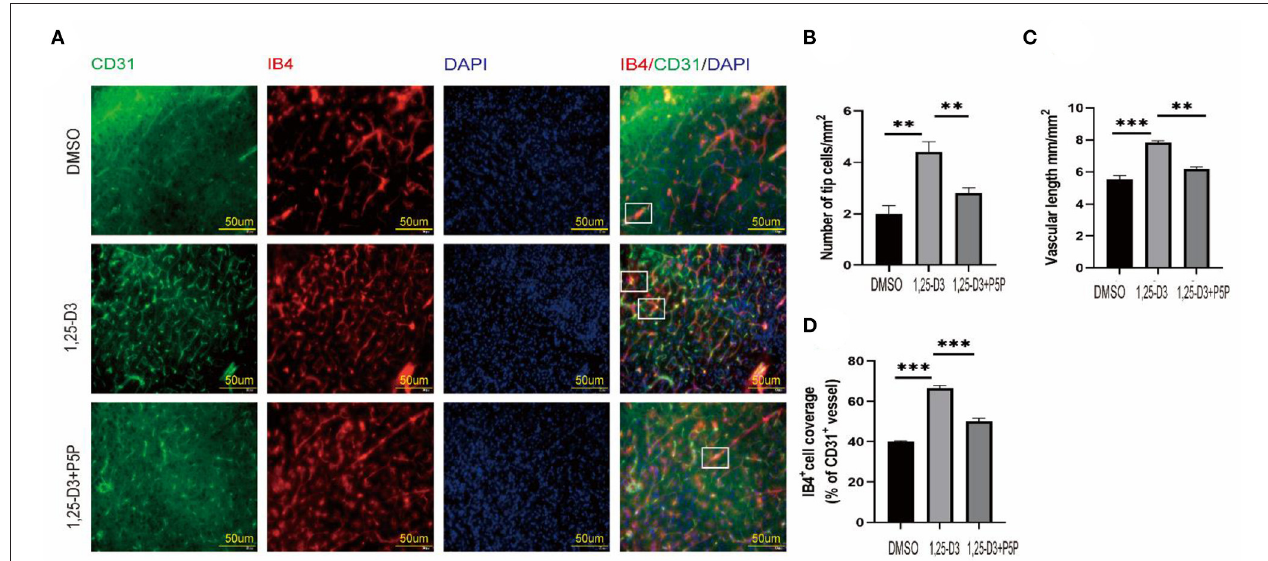
FIGURE 4 | 1,25-D3 increased neovascularization and improved vascular function 3 days after stroke. (A) In situ expression of CD31 (green), IB4 (red) and 4’,6-diamidino-2-phenylindole (DAPI; blue) in the peri-infarct region of DMSO, 1,25-D3 and 1,25-D3 + P5P groups (400 × magnification 400). Levels of IB4 + tip cells (B) , CD31 + vascular length (mm/mm 2 of brain tissue) (C), and IB4 + cell coverage (area ratio of IB4 + and CD31 + ) (D) in the peri-infarct region of DMSO, 1,25-D3 and 1,25-D3 + P5P groups. Data were represented as Mean ± SEM. Data were represented as Mean ± SEM, n = 5 per group, * p < 0.05, ** p < 0.005, *** p < 0.001. MCAO, middle cerebral artery occlusion; DMSO, dimethyl sulfoxide; P5P, antagonist of VDR; 1,25-D3, 1 α ,25-dihydroxyvitamin D3.